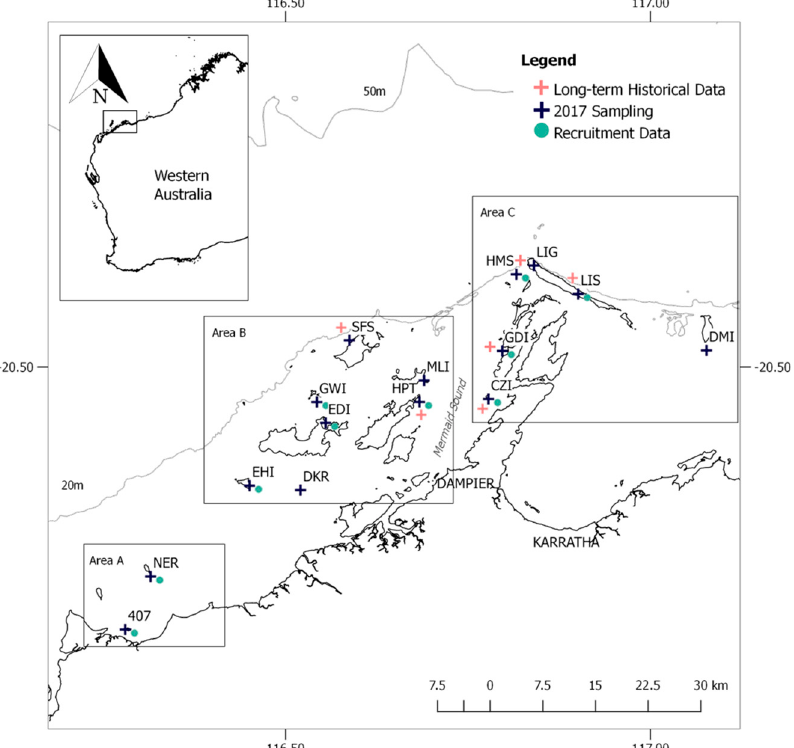
Figure 1. Location of the 15 study sites throughout the Dampier Archipelago, Western Australia, surveyed in 2017. Site abbreviations: 407 = Unnamed 407, NER = North East Regnard, EHI = Eaglehawk Island, DKR = Dockrell Reef, EDI = Enderby Island, GWI=Goodwin Island, HPT = High Point, SFS = Sailfish, MLI = Malus Island, CZI = Conzinc Island, GDI = Gidley Island, HMS = Hammersley Shoal, LIG = Legendre Island Gen, LIS = Legendre Island SZ, DMI = Delambre Island. Areas A, B and C refer to the study area subsections presented in Figure 3.